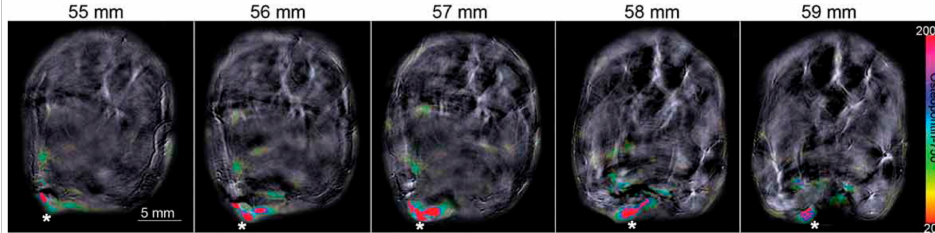
Figure 5. Osteopontin-probe identifies triple-negative breast cancer using multispectral optoacoustic tomography in a murine model. Serial slices are shown with * indicating positive osteopontin-probe uptake within the orthotopic triple negative breast tumor. Adapted from